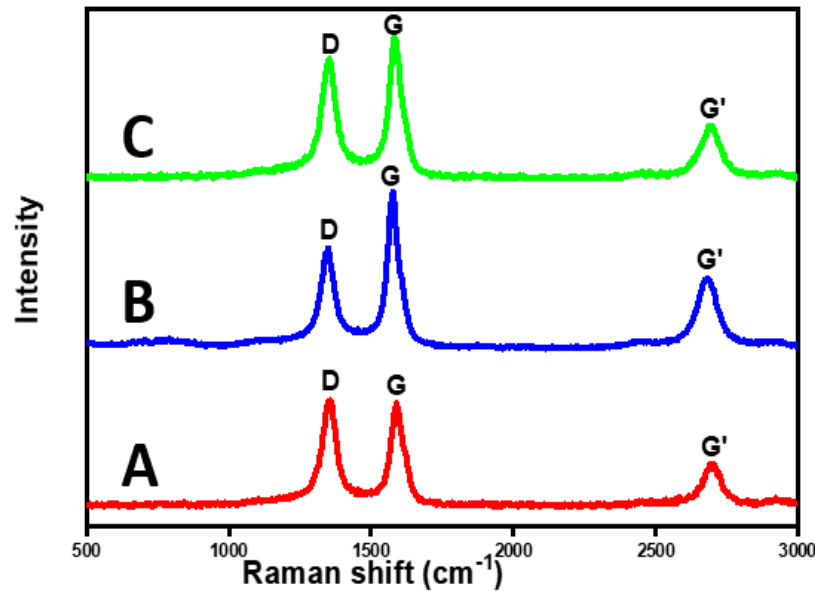
Figure 10. Raman spectra of as-produced CNTs over NiMo/CaTiO 3 catalysts prepared at different calcination temperatures: (A) 600 ℃ , (B) 700 ℃ , and (C) 800 ℃ .